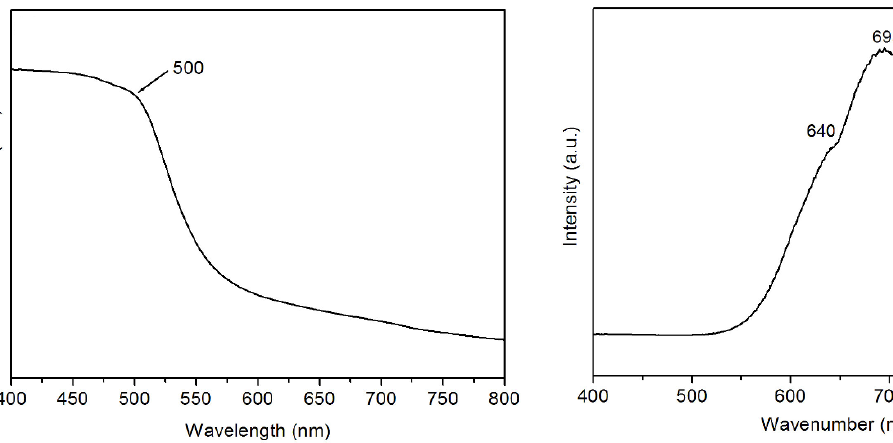
Figure 7. PL spectrum of the polyhedral CdS flower-like architectures at room